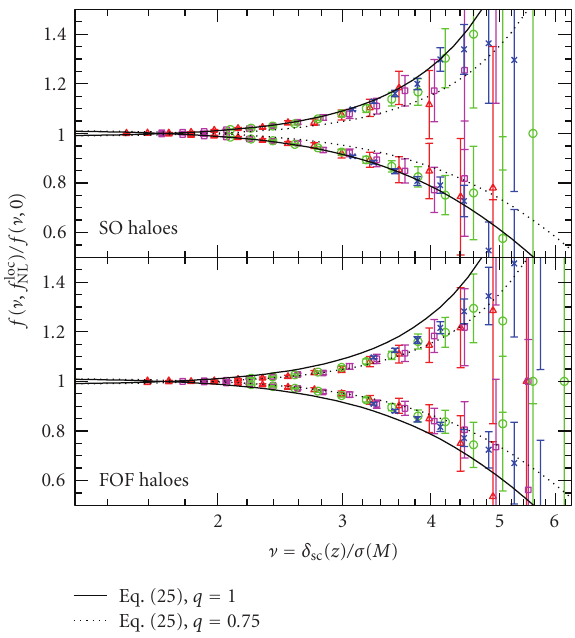
Figure 5: Fractional deviation from the Gaussian mass function as a function of the peak height ν = δ c /σ . Di ff erent symbols refer to di ff erent redshifts as in Figure 4. The curves are the theoretical prediction (25) at z = 0 with q = 1 (solid) and q = 0 . 75 (dotted). In the top panel, halos were identified using a spherical overdensity (SO) finder with a redshift-dependent overdensity threshold Δ vir ( z ) whereas, in the bottom panel, a Friends-of-Friends (FOF) finding algorithm with linking length b = 0 . 2 was